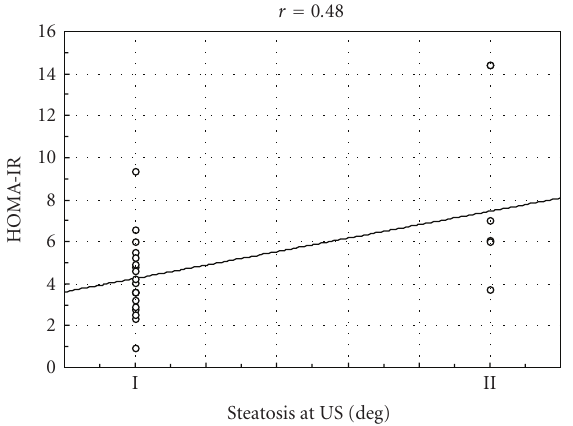
Figure 2: Correlation between degree of steatosis at US and HOMA-IR at baseline conditions of adolescent obese